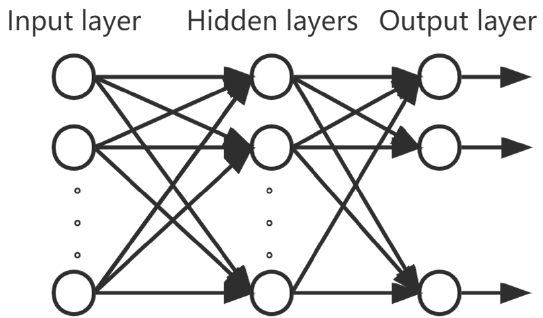
Figure 2. MLP structure diagram.